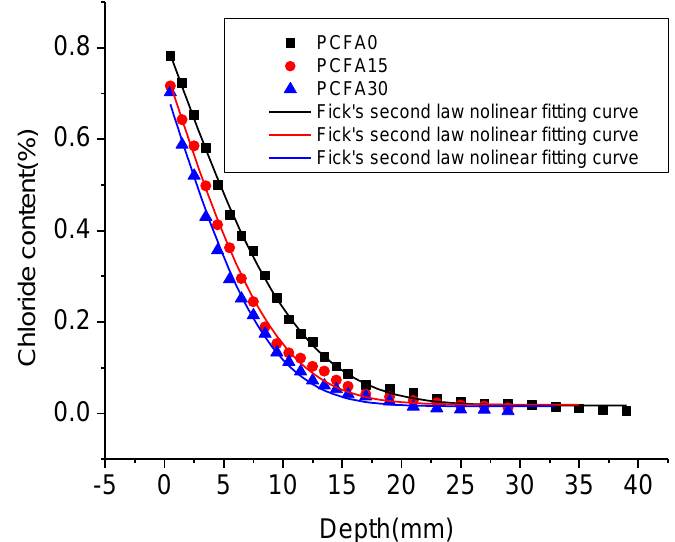
Table 3. Regression results of chloride diffusion coefficient. D: chloride ion diffusion coefficient; C S : chloride percentage at the concrete surface; and σ 2 : the mercury surface tension force.